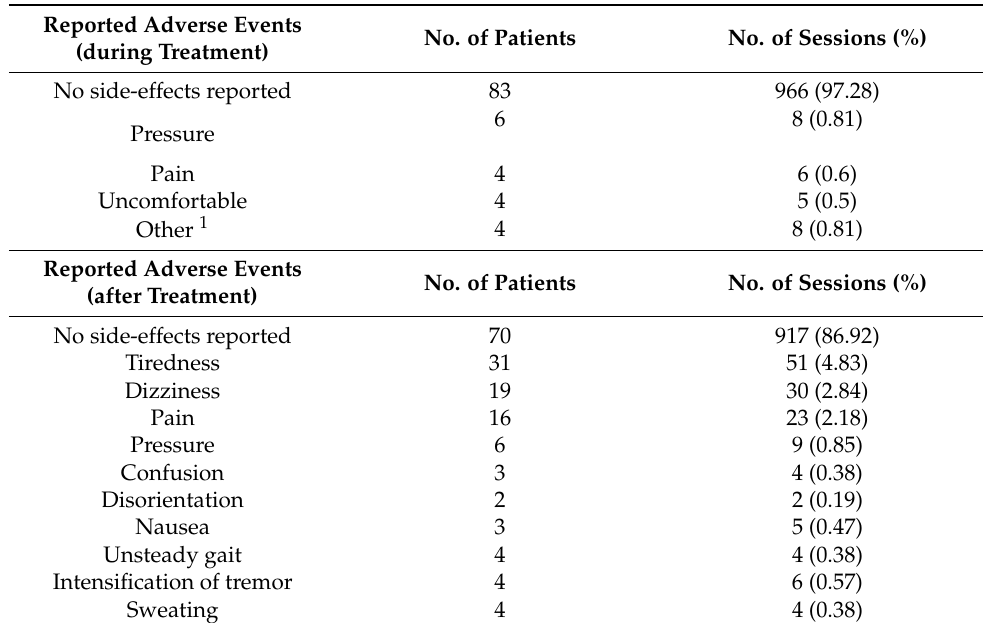
Figure 1. Experienced pressure and pain were rated during TPS treatment. ( A ) Percentages over all sessions and ( B ) number of patients across all sessions. Table 2. Adverse events reported during and after TPS treatment sessions (min. of 10 sessions per patient). Data was taken from all completed questionnaires, and multiple answers